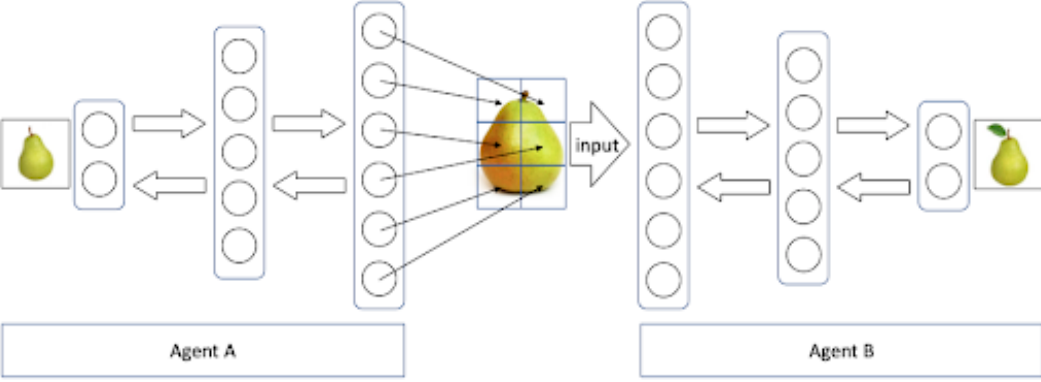
Figure 3. Two communicating ( Agents A , B ) are modelled using two independent neural networks, each of which was trained on different but similar data (here: images of pears). By simple forward computation from higher to lower cortical level, ( Agent A ) generates an image of a pear that is fed into the input layer of ( Agent B ). ( Agent B ) can then recognize the pear, resulting in an effective communication amongst the agents.